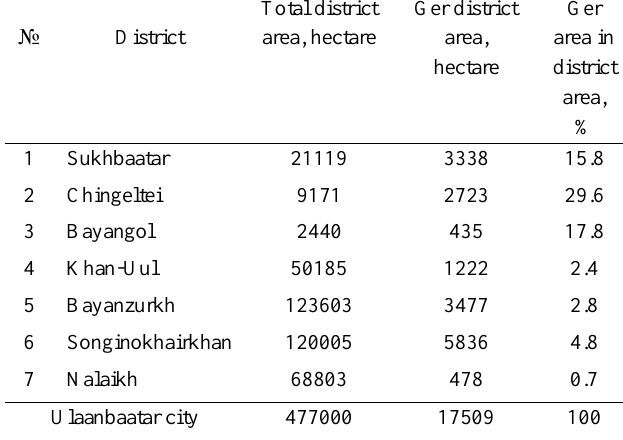
Table 1. Area of districts and ger area of Ulaanbaatar city